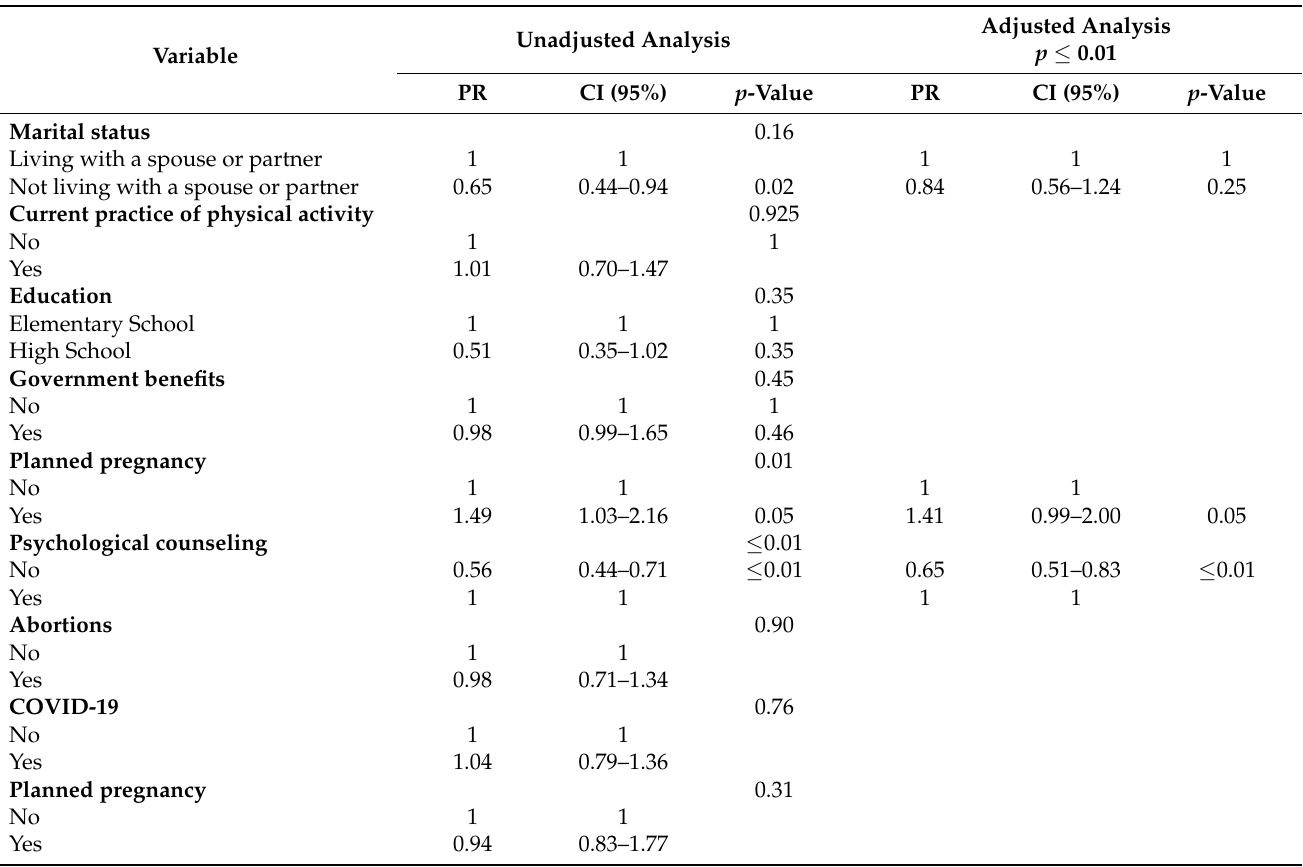
Table 2. Unadjusted and adjusted analysis of socioeconomic and demographic variables and factors associated with depressive symptoms in pregnant women followed up with during prenatal care